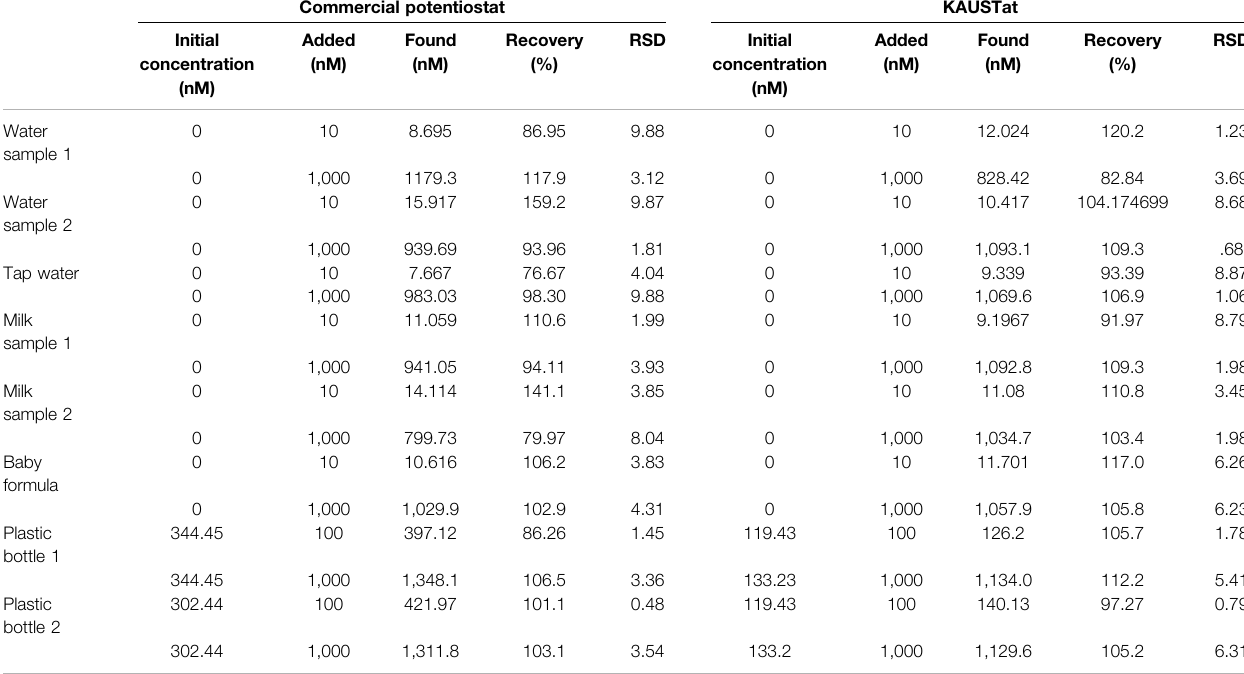
TABLE 1 | Determination of BPA in water, milk and plastic samples by LSG-MIP sensor. Commercial potentiostat